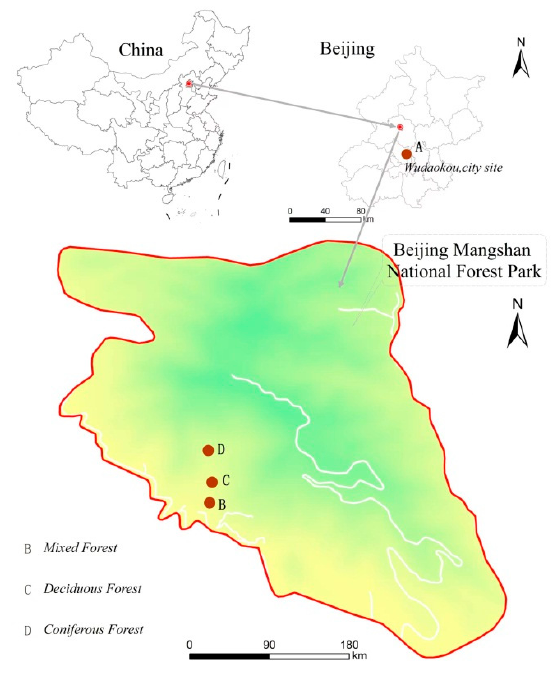
Figure 1. The map of experimental locations.